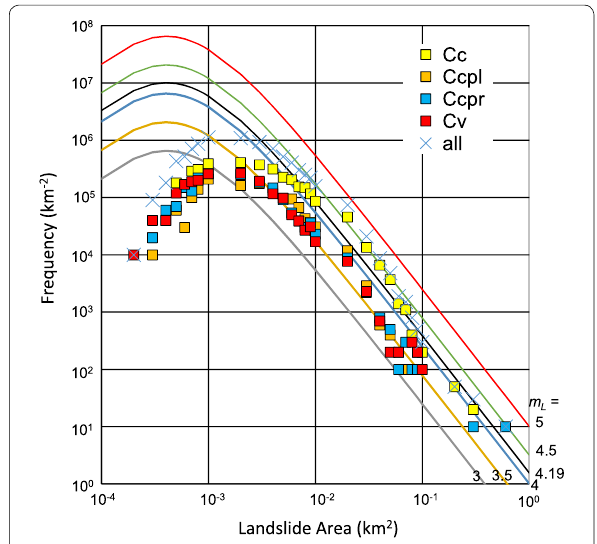
Fig. 15 Frequency-size distribution of landslides for all landslides, and for landslides of each slope type. The distribution curves for m L from 3 to 5 are also shown